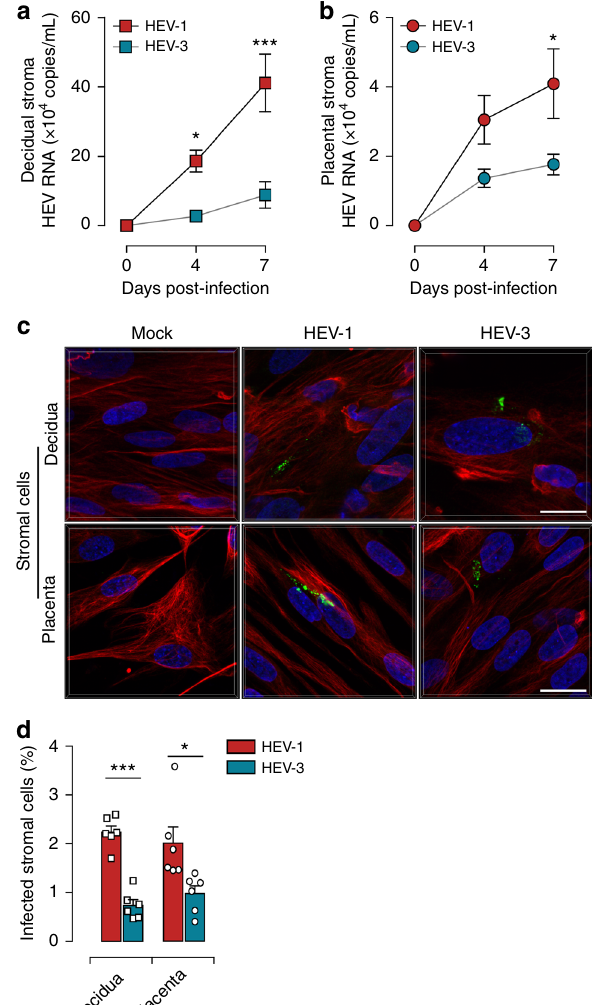
Fig. 6 Primary decidual and placental stromal cells are targets of HEV-1 infection at the maternal-fetal interface. a , b Kinetics of viral RNA production in stromal cells derived from the a decidua or b placenta, infected with either HEV-1 (red) or HEV-3 (cyan). Virus production was determined by RT-qPCR in culture supernatants. c Representative images of stromal cells derived from the decidua (upper panel) or placenta (lower panel), 7 days after mock, HEV-1, or HEV-3 infection. 3D-reconstituted maximum intensity projections are shown, generated using the Imaris software. Staining indicates the ORF2 viral capsid protein (green), vimentin (red), and nuclei (blue). Scale bar, 20 µ m. d Bar graph illustrating the percentage of infected stromal cells derived from the decidua or placenta 7 days after HEV-1 (red) or HEV-3 (cyan) infection and determined by ORF2 staining. Data represent mean values ± S.E.M. of six independent infected cells. * P < 0.05; *** P < 0.001 by two-way ANOVA with